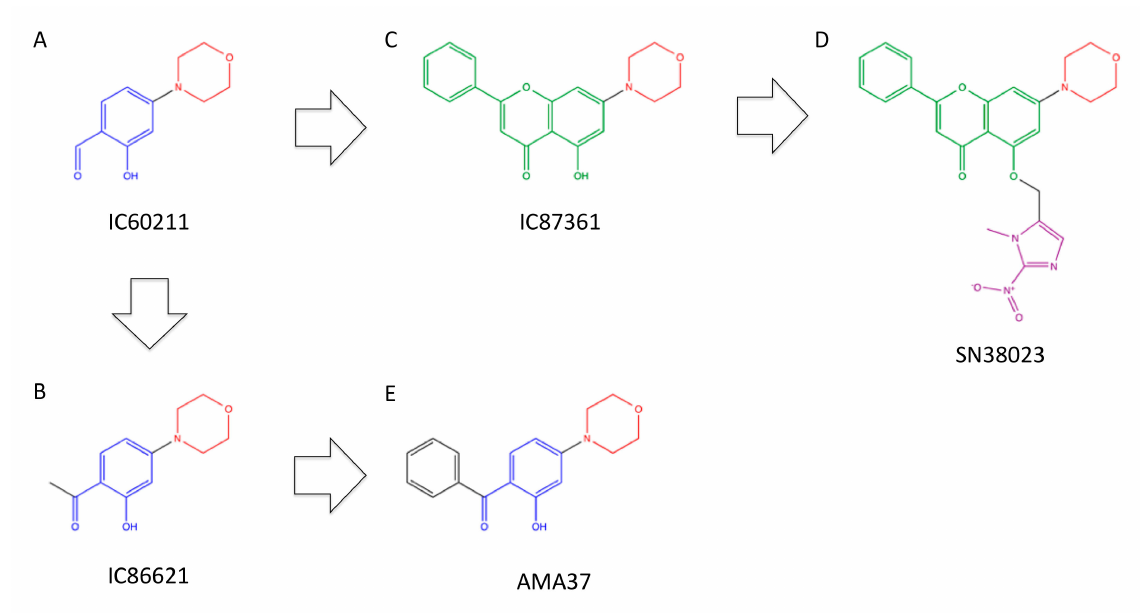
Figure 6. Structures and mutual relationships of arylmorpholine-based inhibitors. ( A ) IC60211, ( B ) IC86621, ( C ) IC87361, ( D ) SN38023, ( E ) AMA37. Red: morpholine structures, blue: o- hydroxybenzaldehyde structures, green: 2-phenyl-4H-chromen-4-one structures, which are common between IC87361 and SN38023, violet: 1-methyl-2-nitro-1H-imidazol-5-yl structure, which is removed in hypoxic